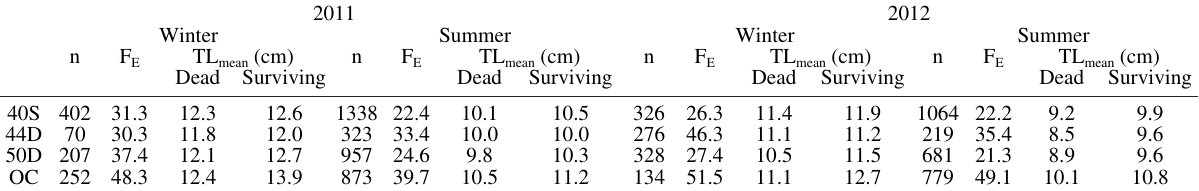
percentage; TL , mean mean